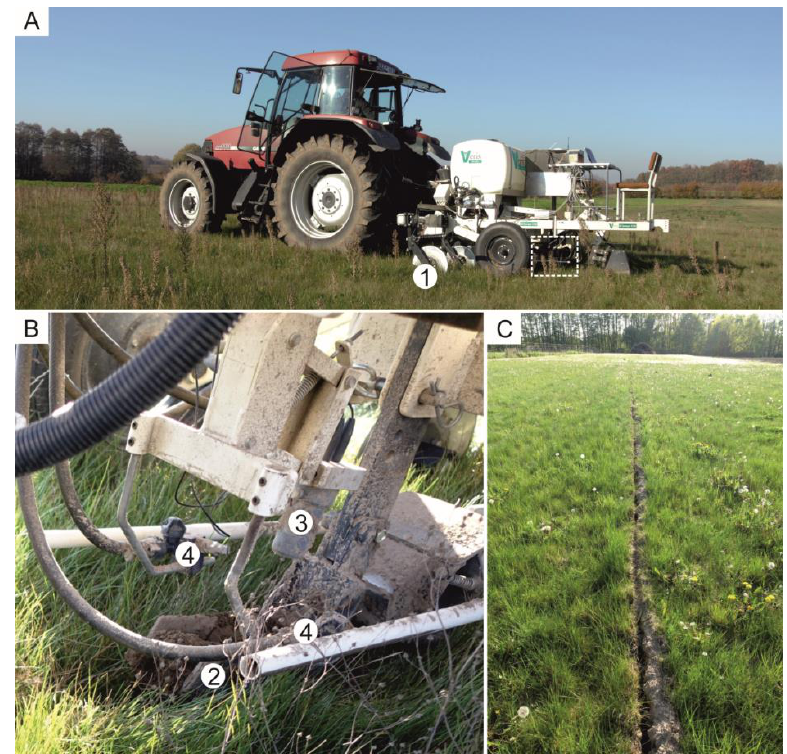
Figure 2. ( A ) Veris mobile sensor platform, ( B ) Veris pH-Manager, and ( C ) furrow cut by the pH sampler trough. Numbers indicate (1) rolling ECa coulter electrodes, (2) pH sampler trough, (3) pH electrodes, and (4) cleaning nozzles.